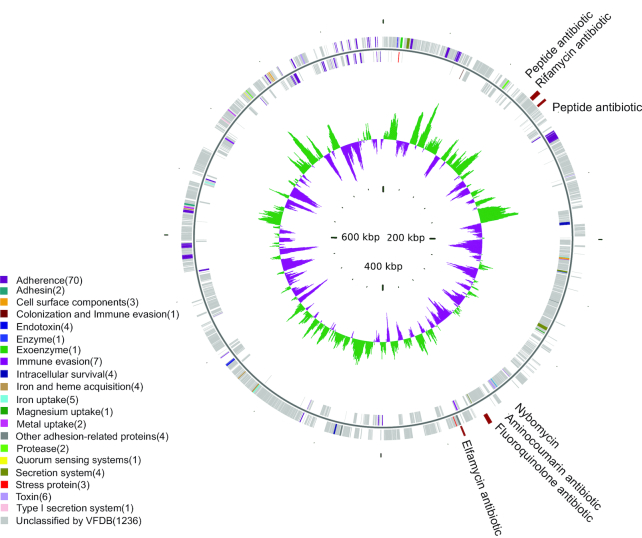
Virulence factor genes (VFGs) and antibiotic resistance genes (ARGs) on the Mycoplasma pneumoniae genome. Tracks from outside to inside represent ARGs, genes on the plus strand, genes on the negative strand, and guanine-cytosine skew, respectively. VFG colours indicate VFG type.